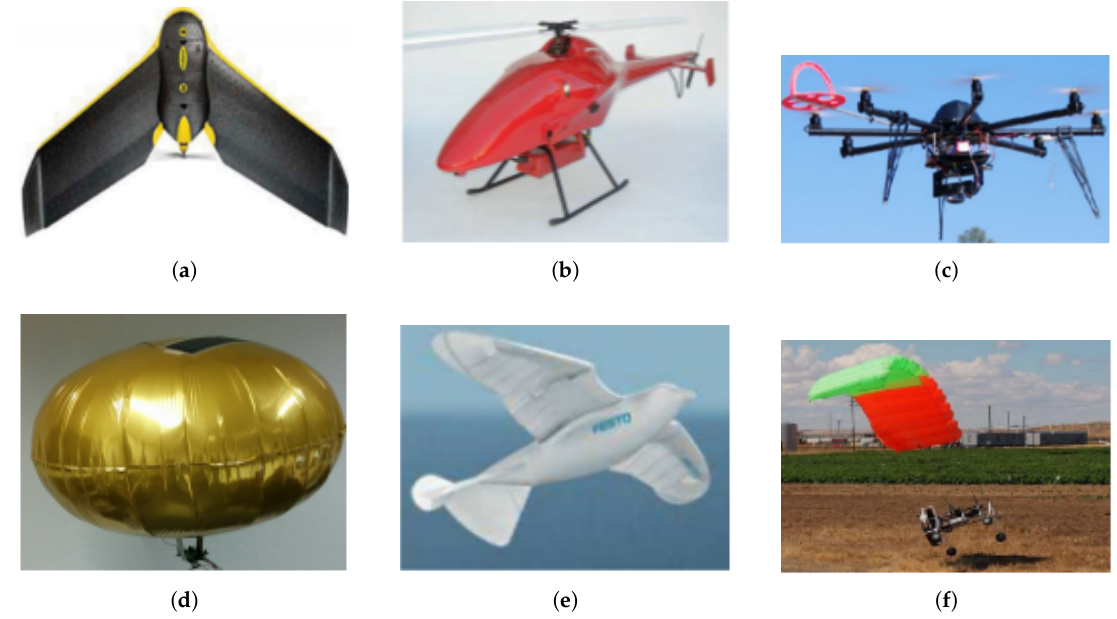
Figure 1. ( a ) Fixed-wing (eBee TM ) [23]; ( b ) helicopter (Hornet Maxi) [122]; ( c ) octocopter [25]; ( d ) blimp [123]; ( e ) flapping-wing (SmartBird) [122]; and ( f ) parafoil-wing (Tetracam)